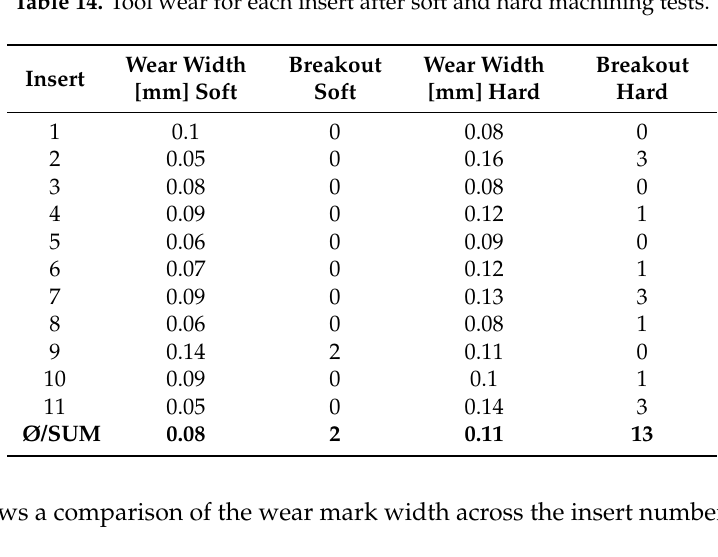
Table 14. Tool wear for each insert after soft and hard machining tests.